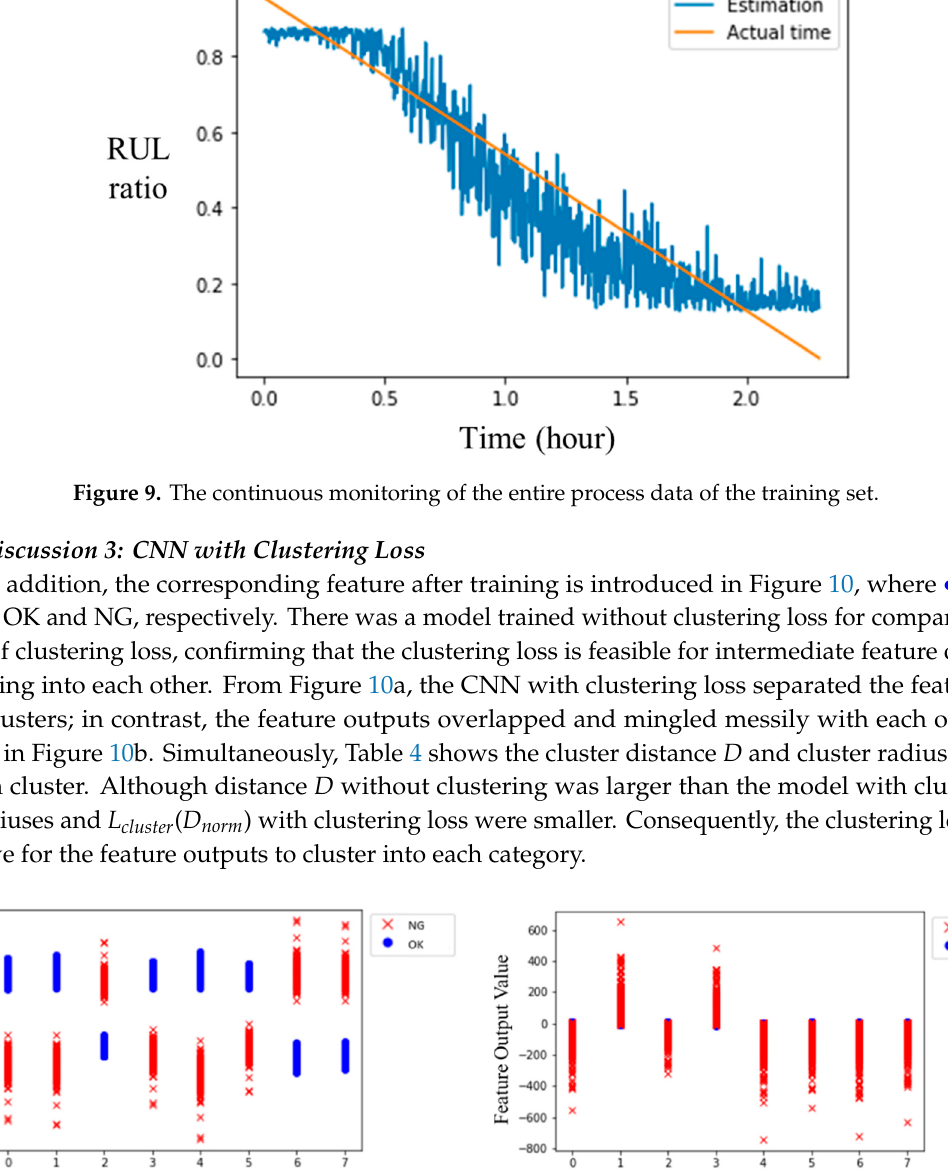
Figure 8. The training bearing remaining useful life (RUL) ratio estimation error comparison graph.